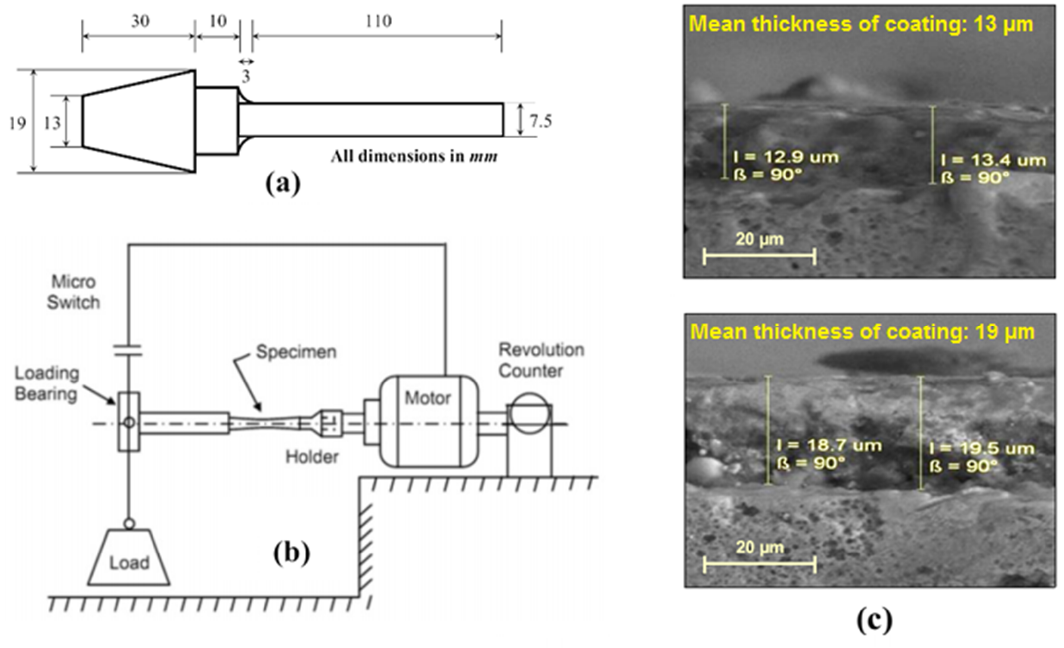
Figure 1. ( a ) Fatigue test specimen and ( b ) Schematic illustration of cantilever rotating bending fatigue equipment used in this study. ( c ) Observed coating thicknesses by SEM, from up to bottom 13 and 19 µm, respectively.